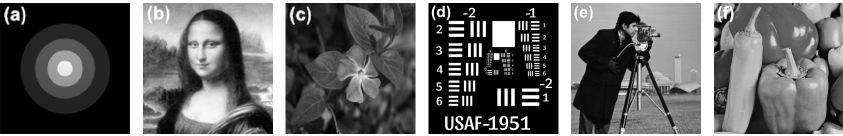
Figure 3. Original object images of the simulations ( a – c ) and experiments ( d – f ).